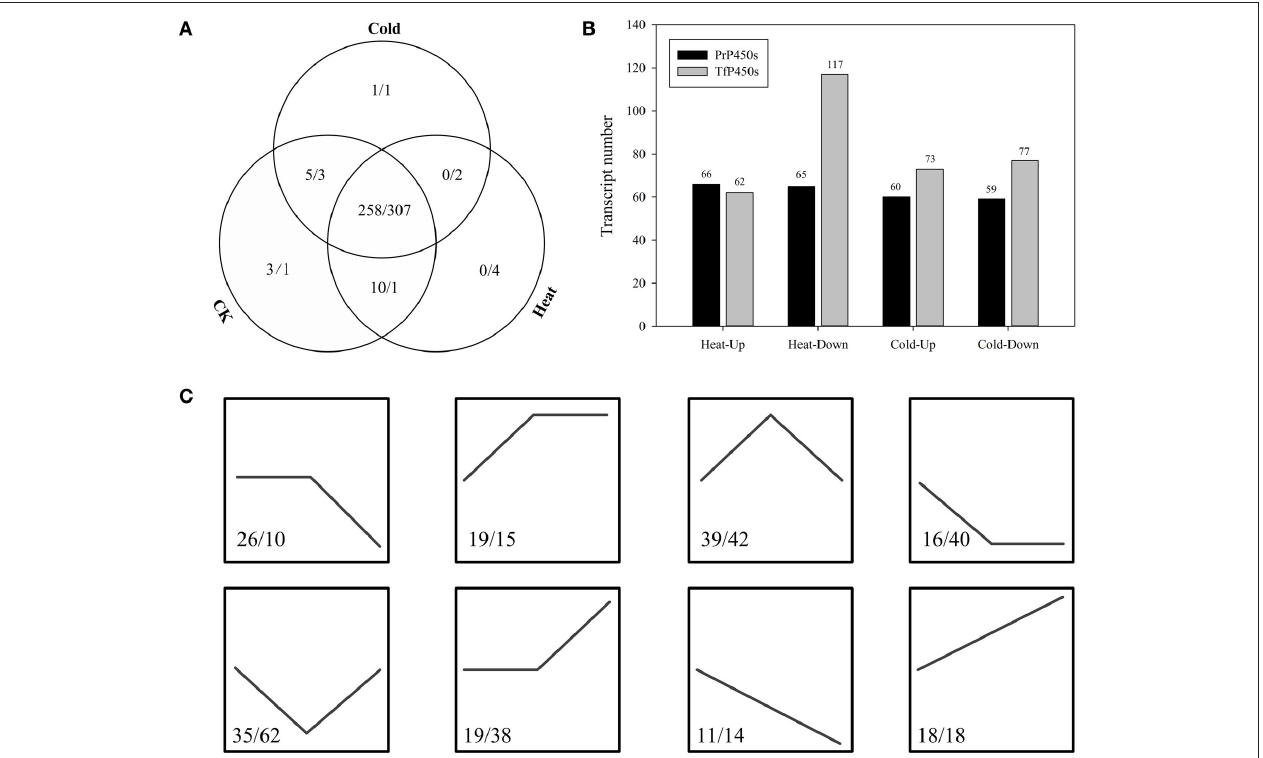
FIGURE 3 | Expression Profiling of the Predicted P450 Transcripts. (A) Expression patterns of P450 transcripts that were identified in perennial ryegrass and tall fescue. (B) Differential expression of P450 transcripts under heat and cold stress. (C) Expression trend of differentially expressed P450 transcripts, where control, heat, and cold were treated as three time points. The numbers before and after the backslash indicate P450 transcript numbers of perennial ryegrass and tall fescue,